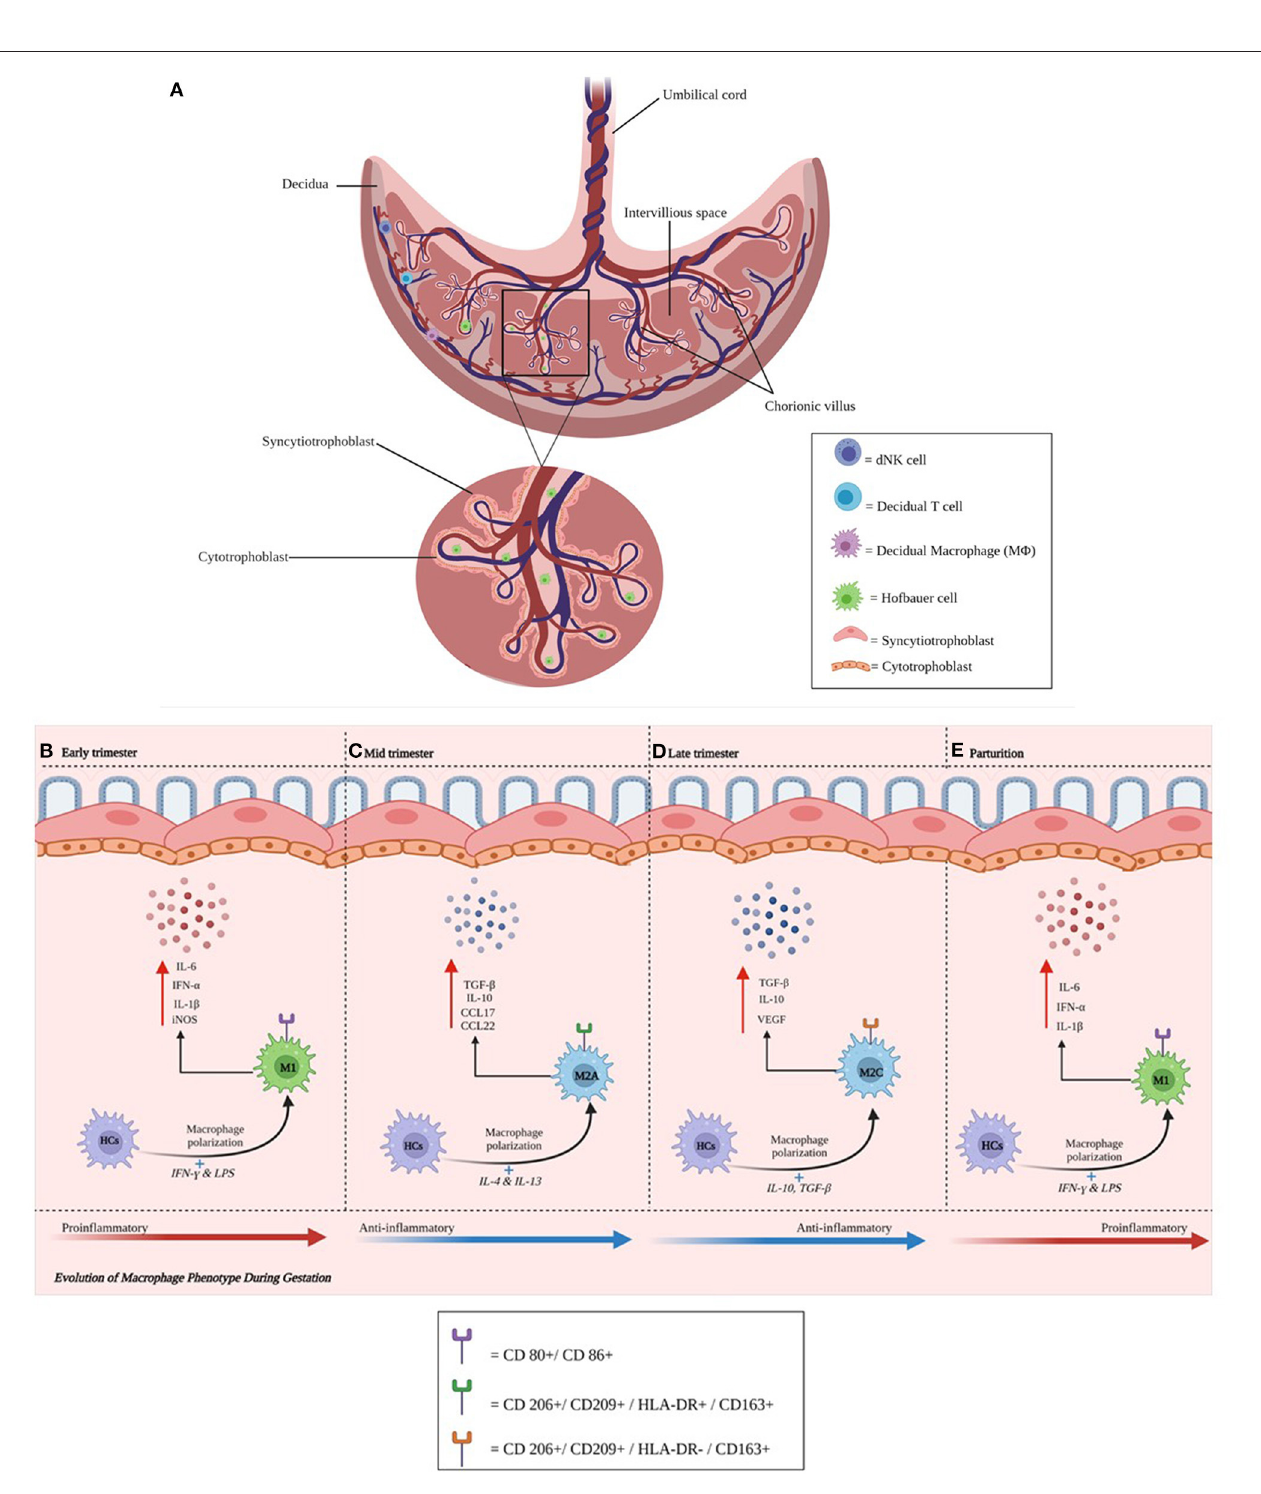
FIGURE 1 | (A–E) Anatomical illustration of the placenta. The placenta plays a critical role in a successful pregnancy and fetal development. Chorionic villi (magnified) support contact with the maternal circulation. Individual cells and their respective locations in the decidua (natural killer, T, and macrophage cells) and villi (Hofbauer cells) are illustrated. Cytotrophoblast cells are found in the decidua basalis and in placental villi, while syncytiotrophoblast cells line placental villi. This interface facilitates delivery of nutrients and oxygen from endometrial arteries. During maternal infection, pathogens may breach the trophoblast layer and migrate toward the fetal side of the interface. HCs change their phenotype during gestation. Activated HCs are abundant in early pregnancy and become regulatory thereafter until parturition. (B–E) Represents the phenotypic changes that Hofbauer cells undergo during gestation.